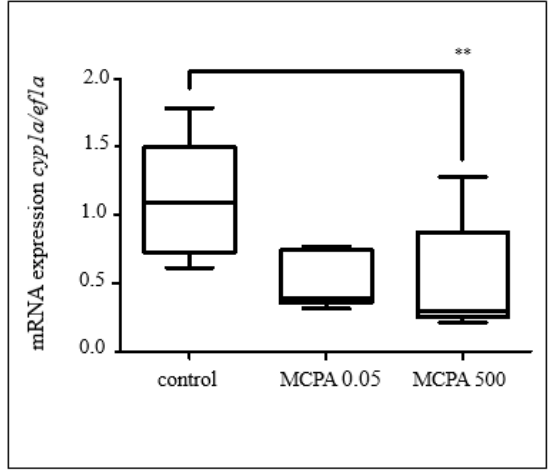
Figure 2. Relative mRNA expression of selected genes in C. carpio embryos exposed to MCPA. Concentrations are indicated in µg/L. Box plot graphs were constructed using median, Q1, and Q2 with whiskers of a maximum 1.5 interquartile range. Statistically significant differences are indicated by ** ( p < 0.01).